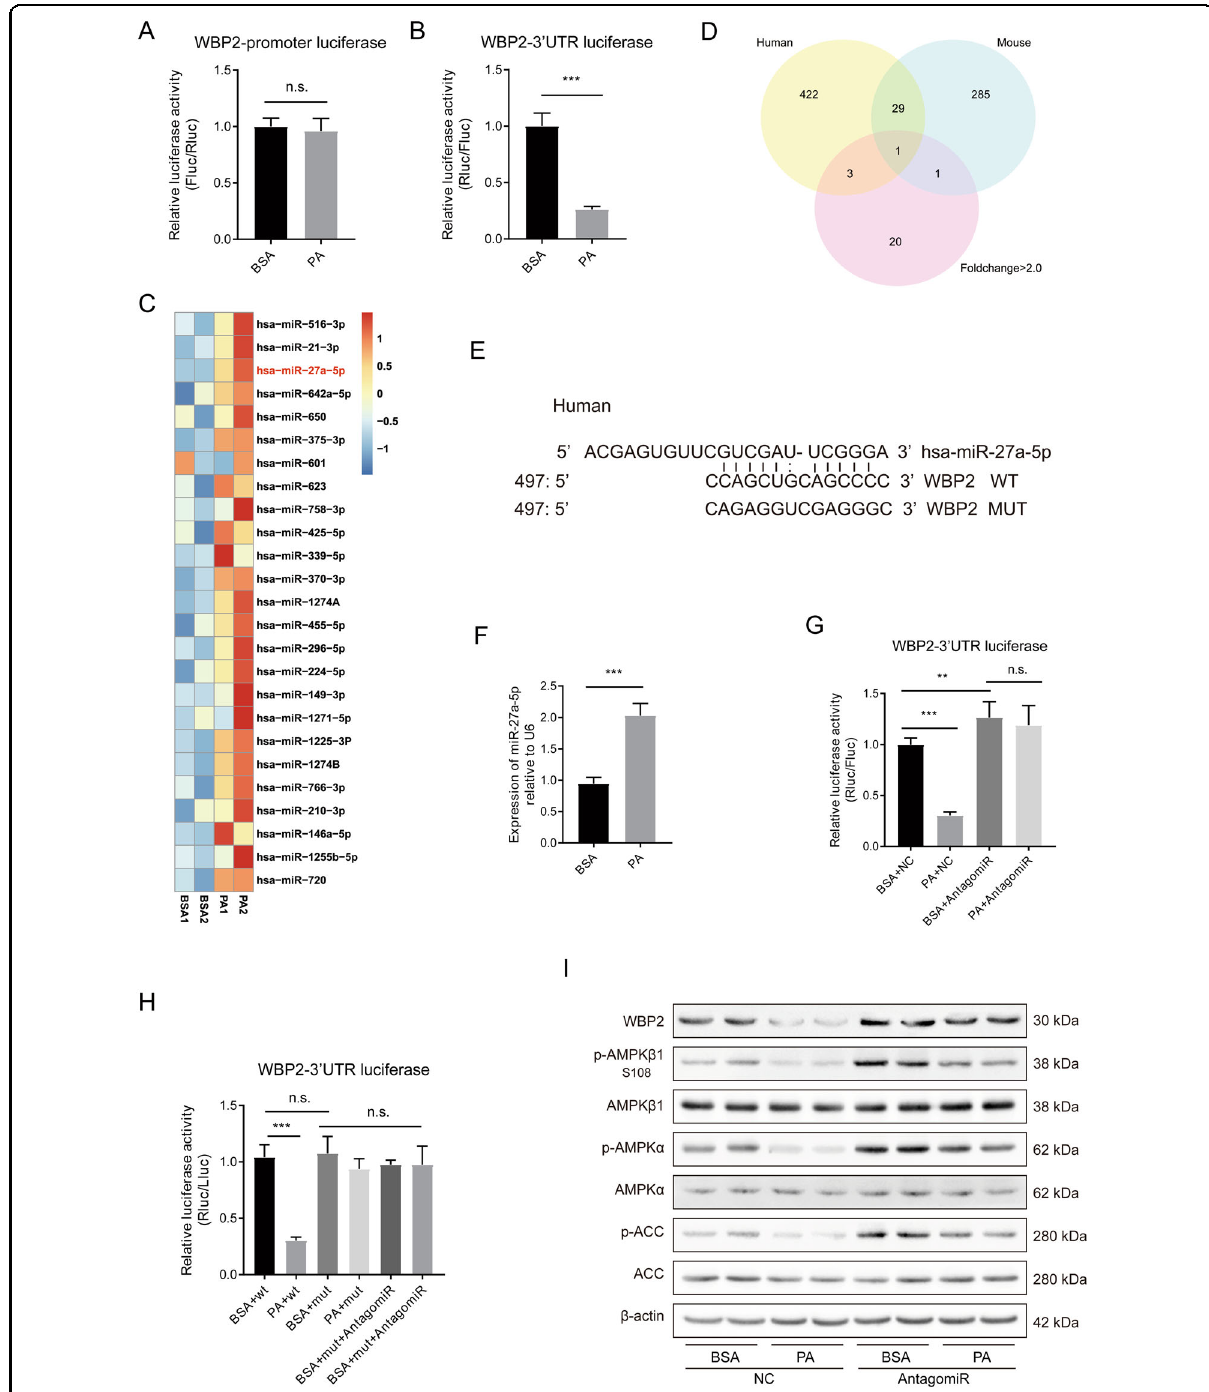
Fig. 8 (See legend on next